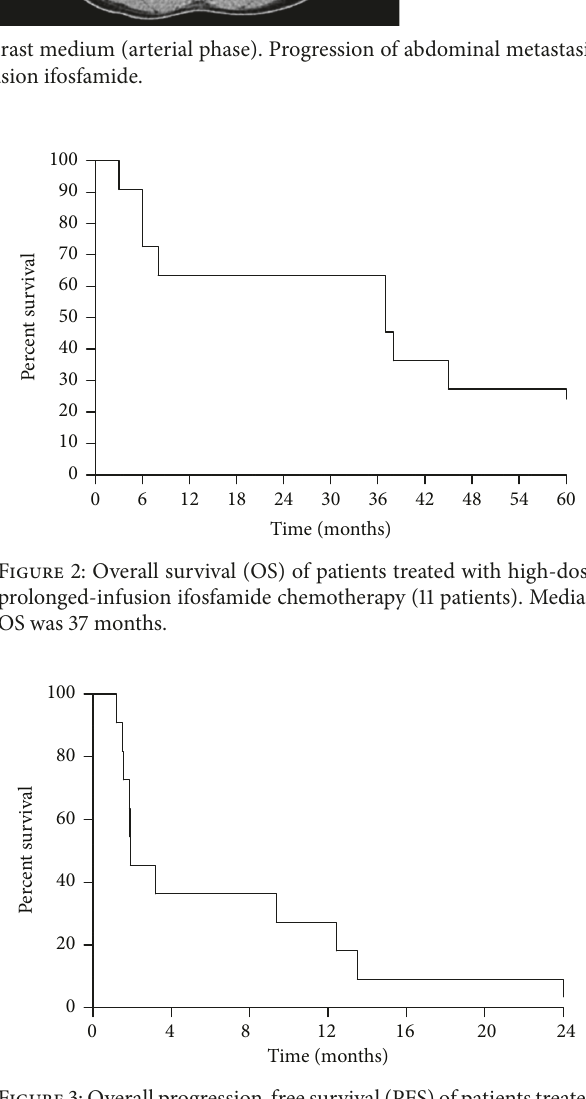
Figure 3: Overall progression-free survival (PFS) of patients treated with high-dose prolonged-infusion ifosfamide chemotherapy (11 patients). Median PFS was 1.9